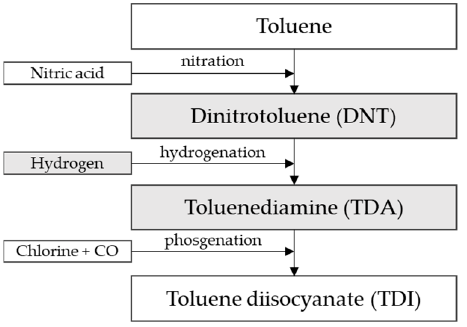
Figure 1. TDI production process from toluene [25]